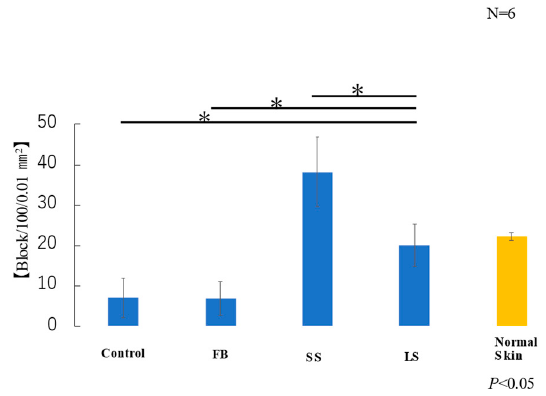
Figure 8. Area of elastic fibers (* p < 0.05).